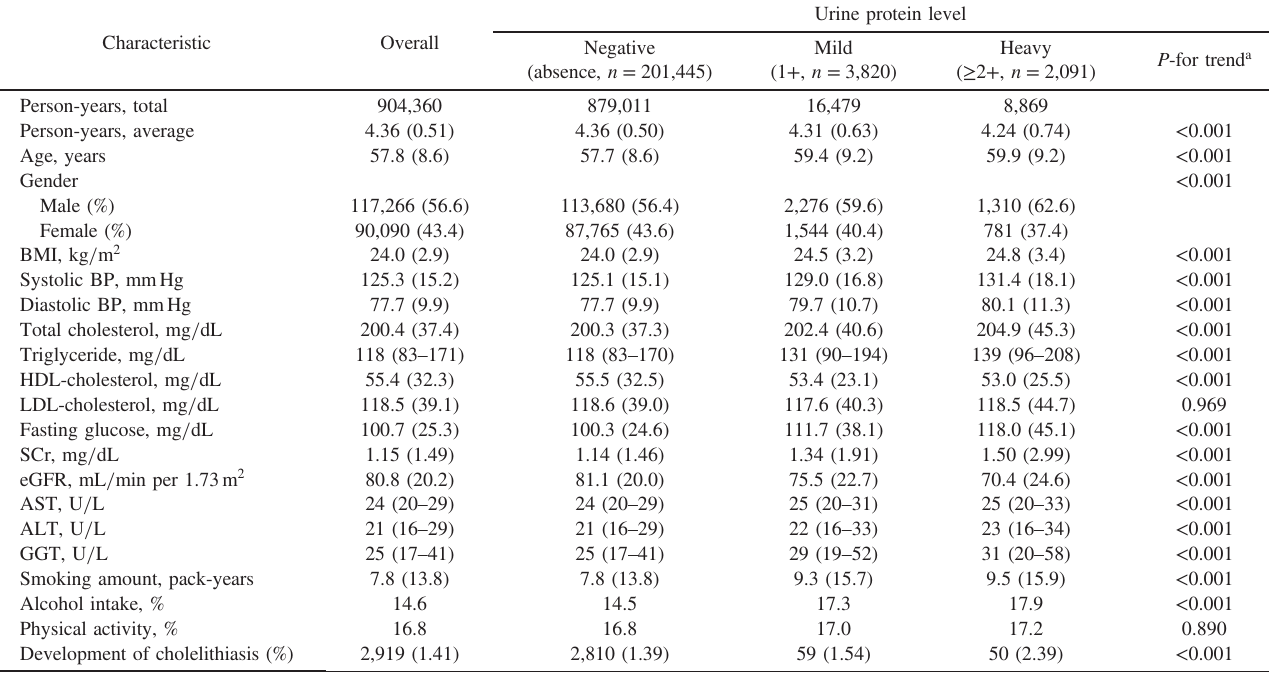
Table 1. Baseline characteristics of participants according to the four groups of urine protein levels Characteristic